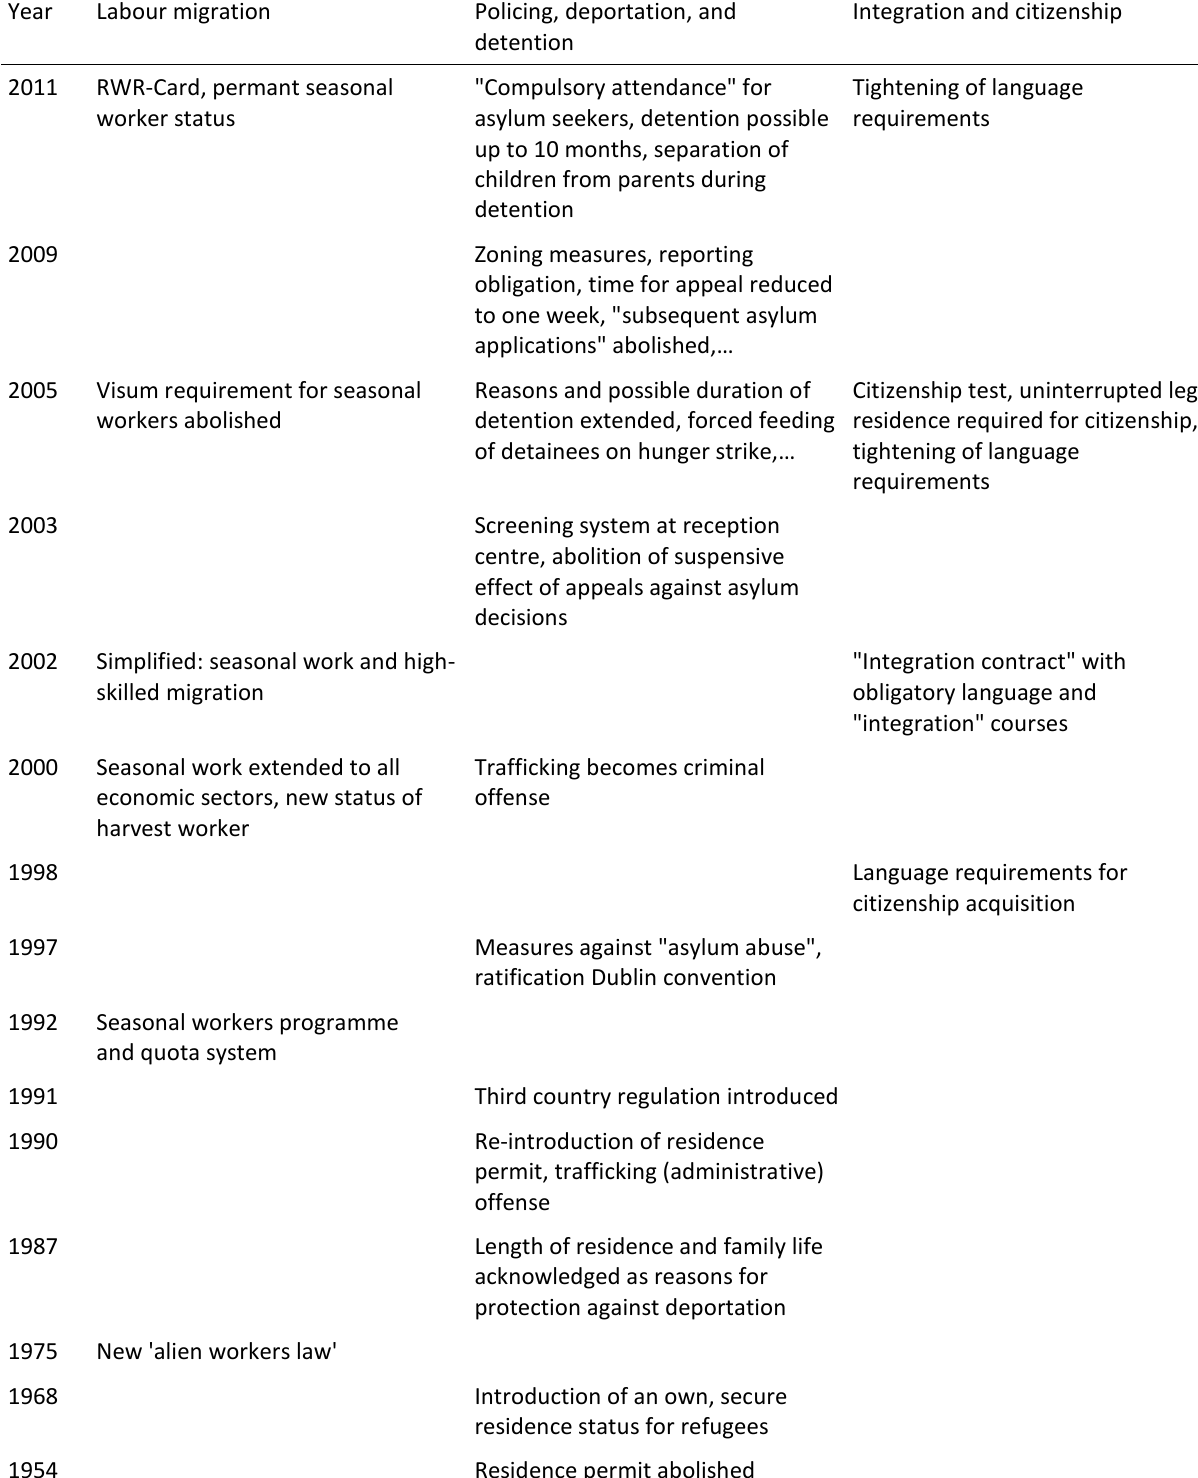
Table 1. Selection of changes to the Austrian migration regime over